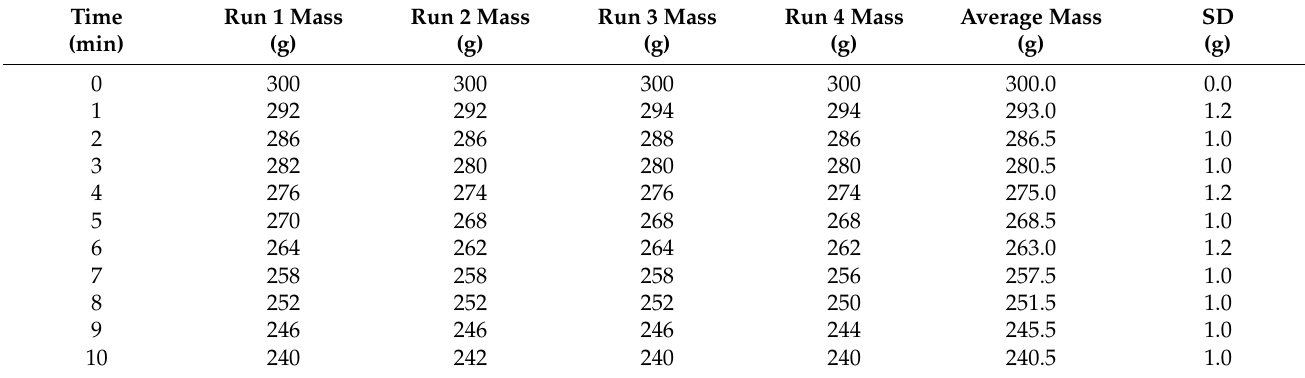
Table A4. Configuration D mass